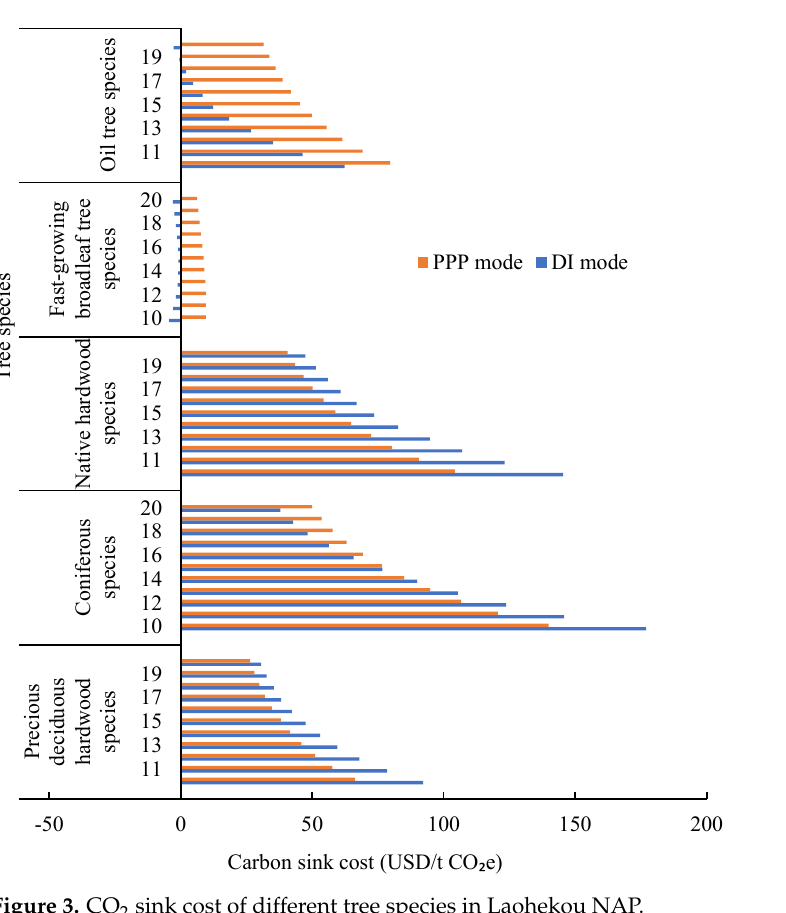
Figure 3. CO 2 sink cost of different tree species in Laohekou NAP.